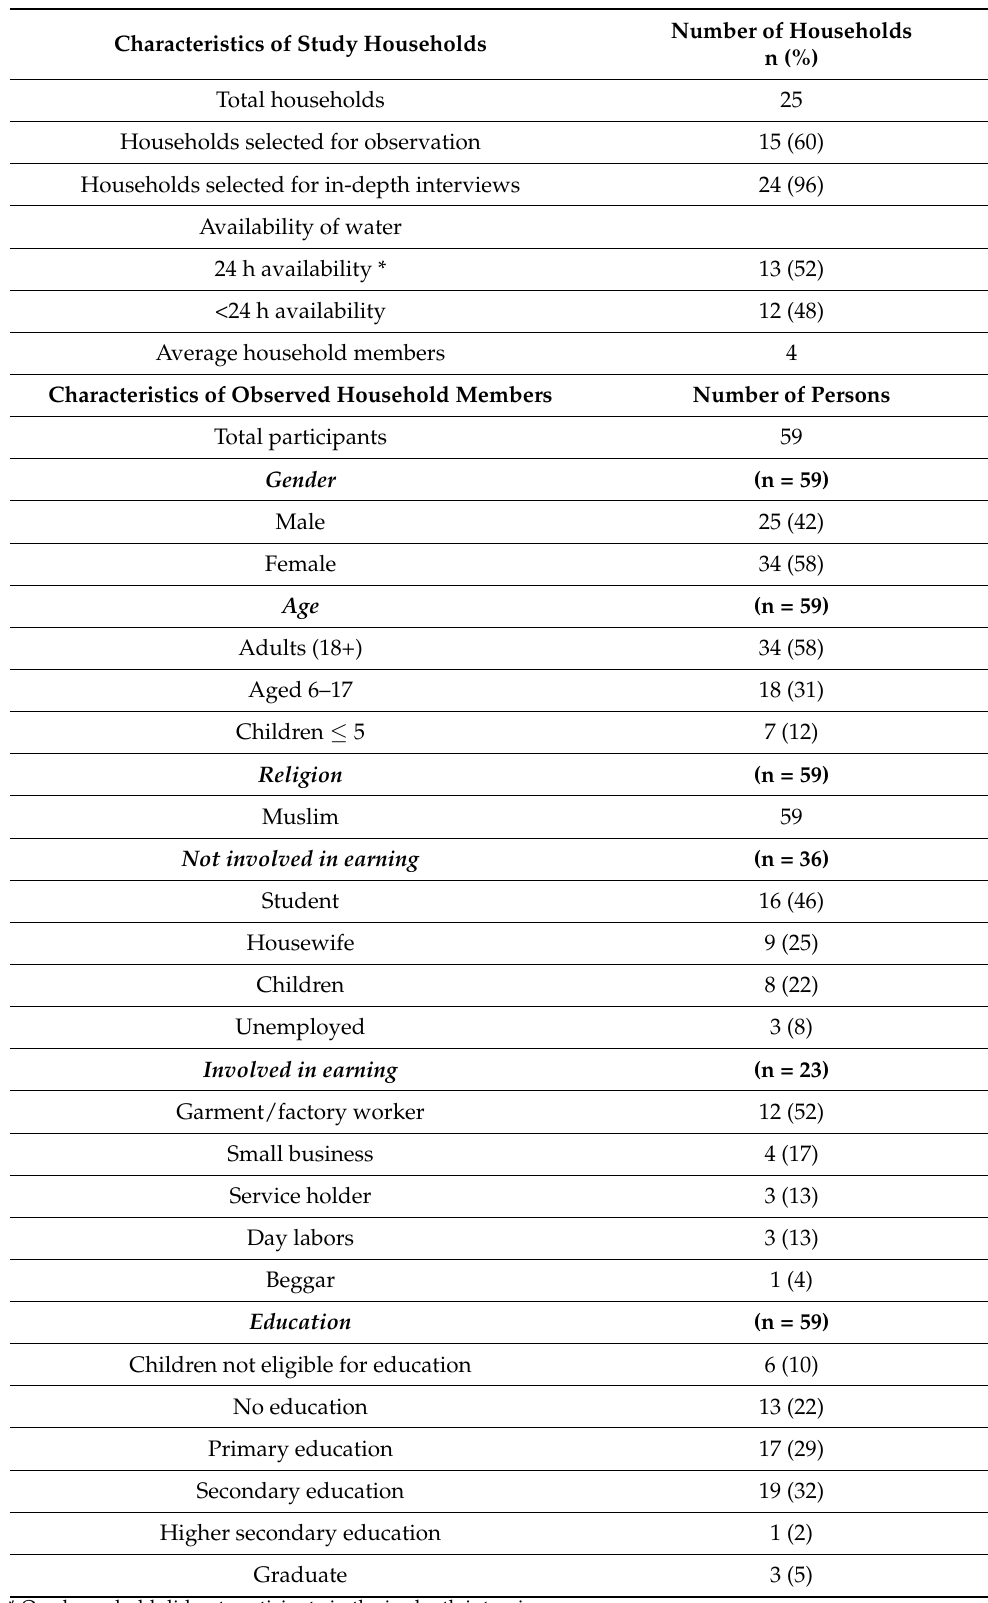
Number of Households n (%)